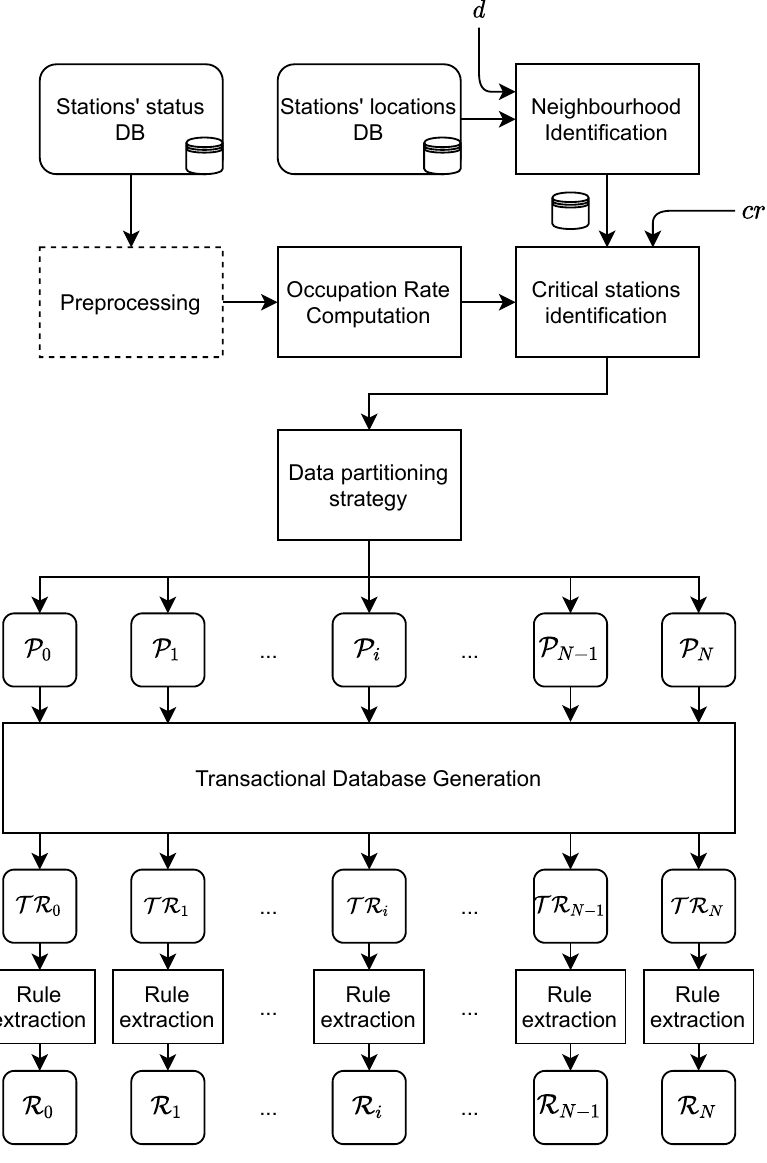
Figure 1. Framework structure at training